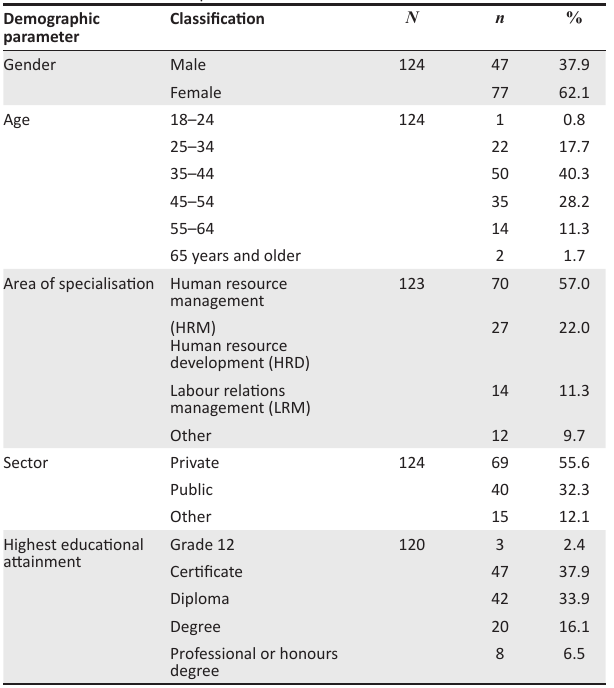
TABLE 1 : Profile of the